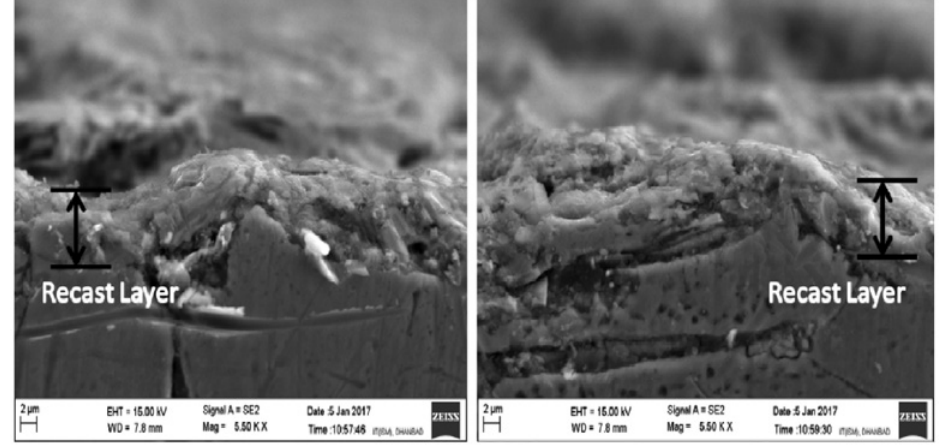
Figure 11: Recast top layer created during WED turning of MMCs.